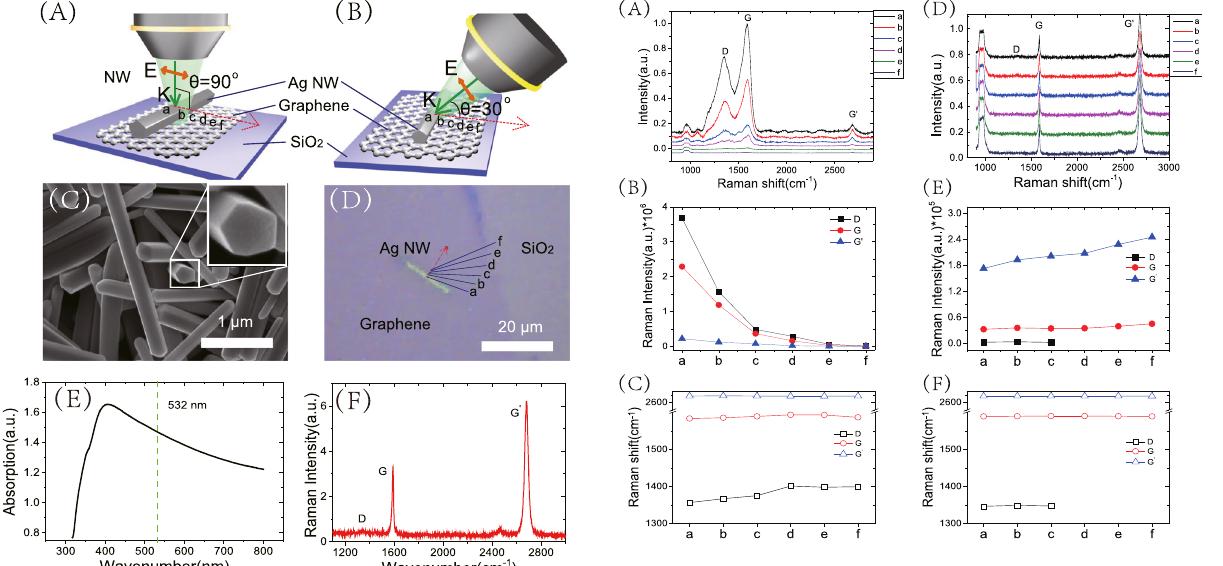
Figure 1: Schematic diagram of a graphene-coupled Ag nanowire (NW) hybrid nanostructure under a microscopy and SERS measure- ment with normal incidence (A) ( θ = 90 ° ) and oblique incidence of the laser on the Ag NW and graphene/SiO 2 -substrate (B) ( θ = 30 ° ). Thepolarizationdirection E ofthelaserisalongthetransversecross section of the NWs. Here θ is the incidence angle between the propagation direction K and the surface of the substrate. (C) Scan- ning electron microscope (SEM) image of Ag NWs; the insets show the top view of vertically standing NWs clearly demonstrating their pentagonal cross sections highlighted in the rectangle. (D) A single NW deposited on the single-layer graphene (SLG) image was viewed under a Zeiss microscope. The blue color part under the NW is the SLG. The edge of the SLG is highlighted by the rectangle. (E) UV – visible absorption spectrum of the Ag NWs sample. (F) The Raman spectrum of the SLG prepared by CVD method. The scaler bars shown in C and D are 1 and 20 μ m, respectively.